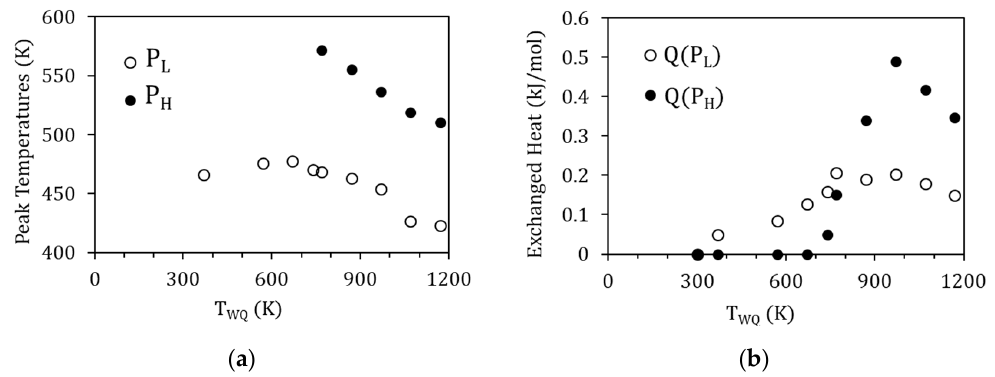
Figure 7. ( a ) Peak temperature of P L and P H as a function of the quenching temperature T WQ; ( b ) evolution with T WQ of the heat released during P L and P H (Q(P L ) and Q(P H ), respectively).